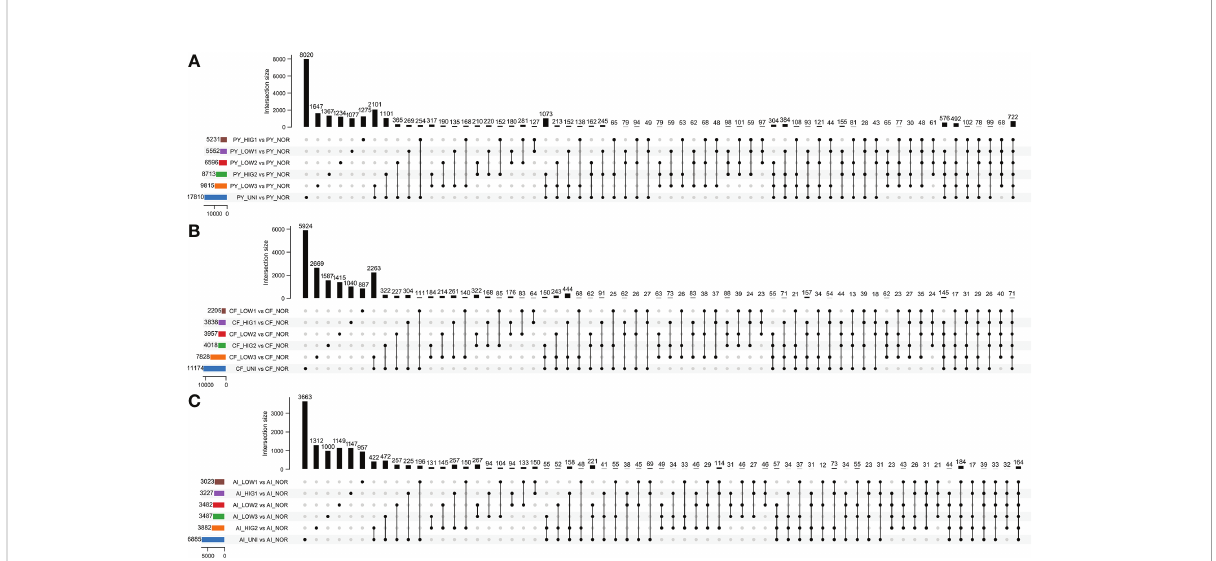
FIGURE 5 Venn diagrams representing DEGs in the Yesso scallop (A) , Zhikong scallop (B) , and bay scallop (C) under stress. (PY, Patinopecten yessoensis ; CF, Chlamys farreri ; AI, Argopecten irradians ; HIG1 and HIG2, heat stress at 22 and 25°C; LOW1-LOW3, hypoxia stress induced by DO levels of 6 mg/L, 4 mg/L, and 2 mg/L, respectively; UNI, stress induced by heat and hypoxia at 25°C and 2 mg/L DO; NOR, normal conditions at 15°C and 8 mg/L DO).